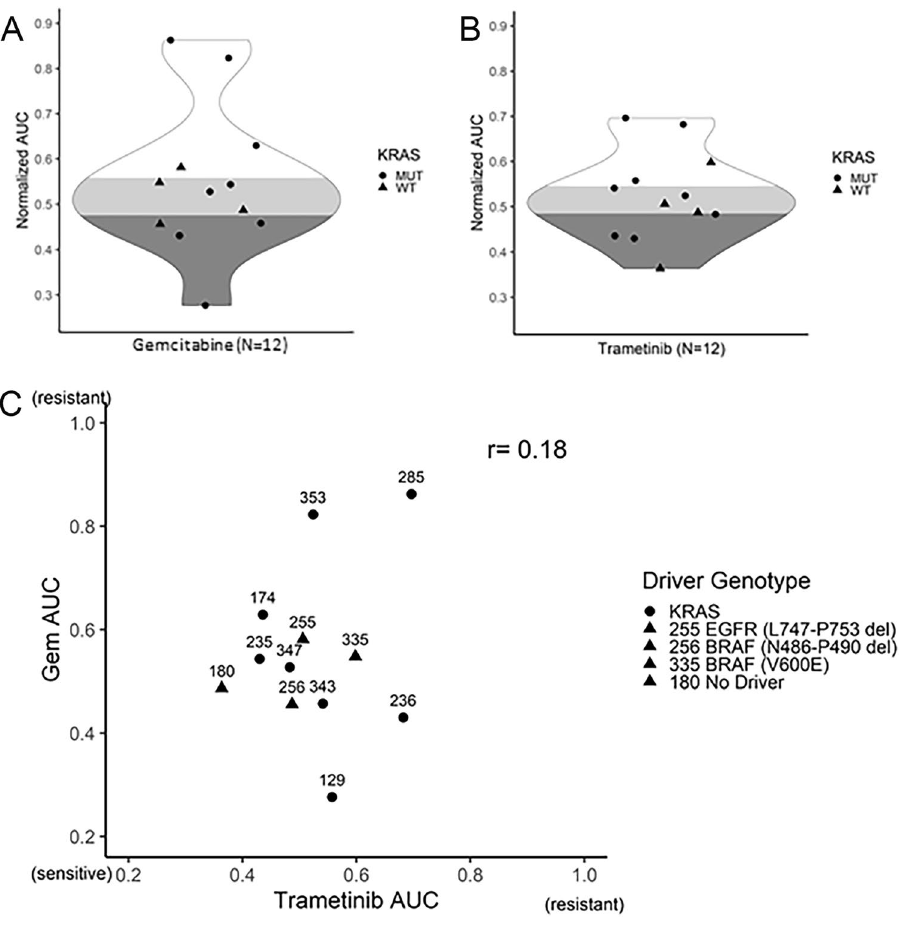
Figure 4. Drug dose responses of XDO models. ( A ) Gemcitabine and ( B ) trametinib cell viability scores were calculated by area under the curve (AUC) for KRAS mutant and wild-type models. Cell viability was measured using a Celltiter Glo 3D assay. ( C ) The scatter plot of organoid AUC scores were compared for both drugs. Model OCIP180 was identified as No Driver (triple negative KRAS / BRAF/EGFR